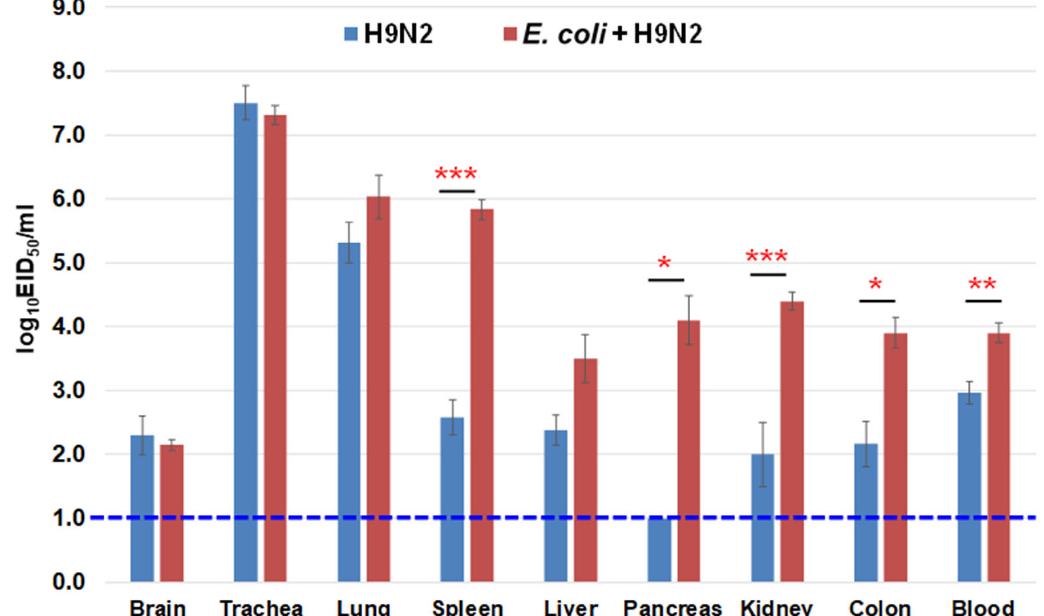
Figure 6. Virus recovery from the internal organs of chickens inoculated with E. coli O2 and H9 LPAIV. The chickens were inoculated intranasally with 10 9.0 CFU of E. coli O2 two days prior to challenge with 10 6.0 EID 50 of a representative H9 LPAIV (A/chicken/Vietnam/HU8-1860/2017 (H9N2) in the red circle of Figure 1). Virus titers in the organs of chickens collected at 3 dpi. Bars indicate the standard error of mean. Statistical significance was calculated using Tukey’s test. Significant differences in virus titers between groups are indicated by * ( p < 0.05), ** ( p < 0.01), and *** ( p < 0.001). The dotted line indicates the detection limit of the test.